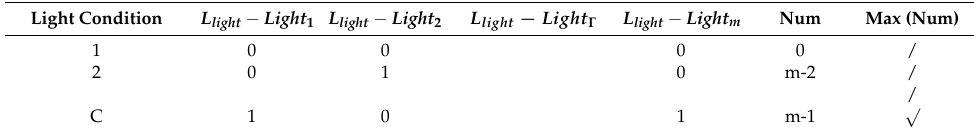
Table 2. Example of selecting light segment result.